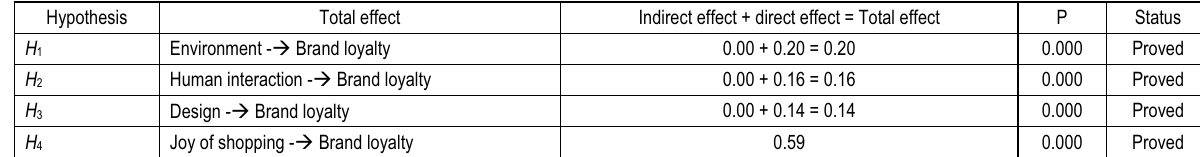
Table 9. Total standardized regression